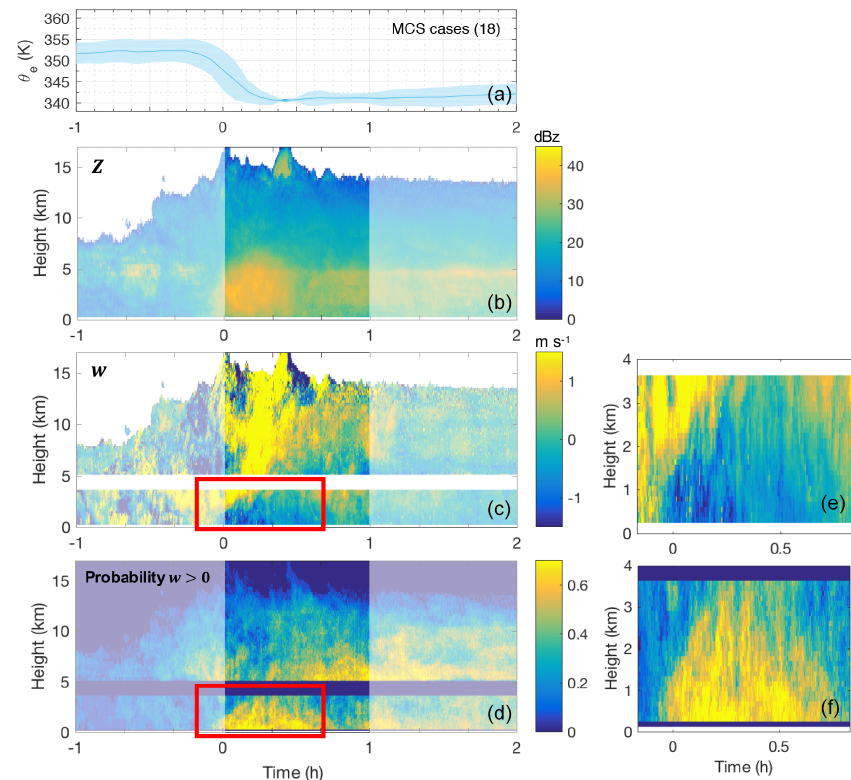
Figure 5. Same as Fig. 5, but leading and lagging the passage of